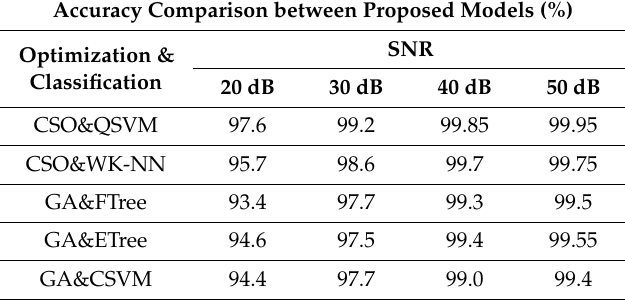
Table 3. Recognition accuracy comparison between proposed methods under noisy